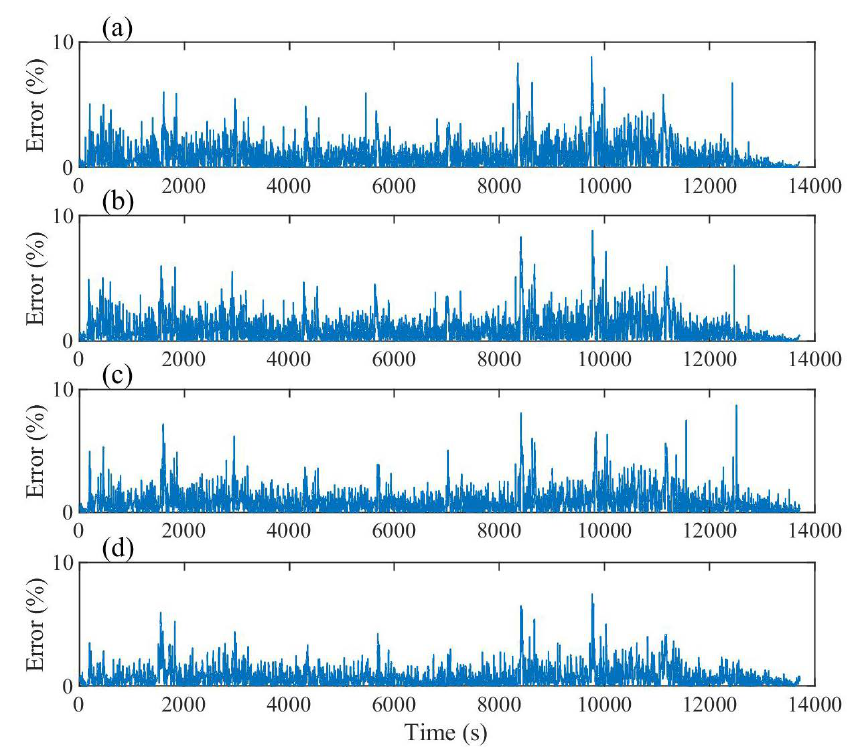
Figure 8. SOC estimation error of the UDDS profile in the four modes: ( a ) first mode, ( b ) second mode, ( c ) third mode, and ( d ) fourth mode.